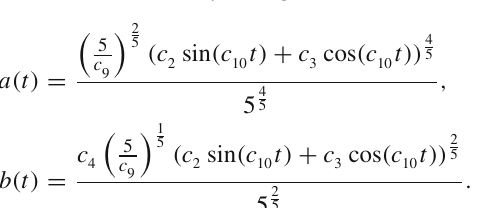
˙ φ 2 ( right ) for (cid:13) = 2